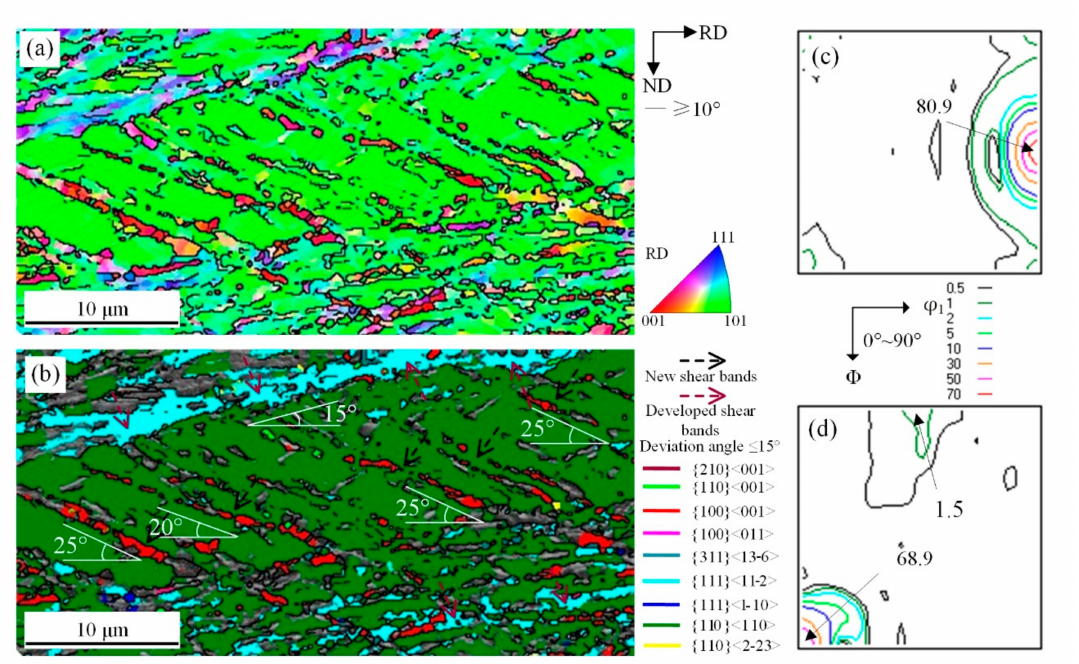
Figure 6. EBSD orientation maps of shear bands with {110}<110> under 77% reduction ( a ) ESBD inverse pole figure of cold-rolled sheet; ( b ) several texture components colored in orientation maps of cold-rolled sheet (deviation angle ≤ 15 ◦ ); ( c ) ODF of EBSD data presented at ϕ 2 = 0 ◦ section; ( d ) ODF of EBSD data presented at ϕ 2 = 45 ◦